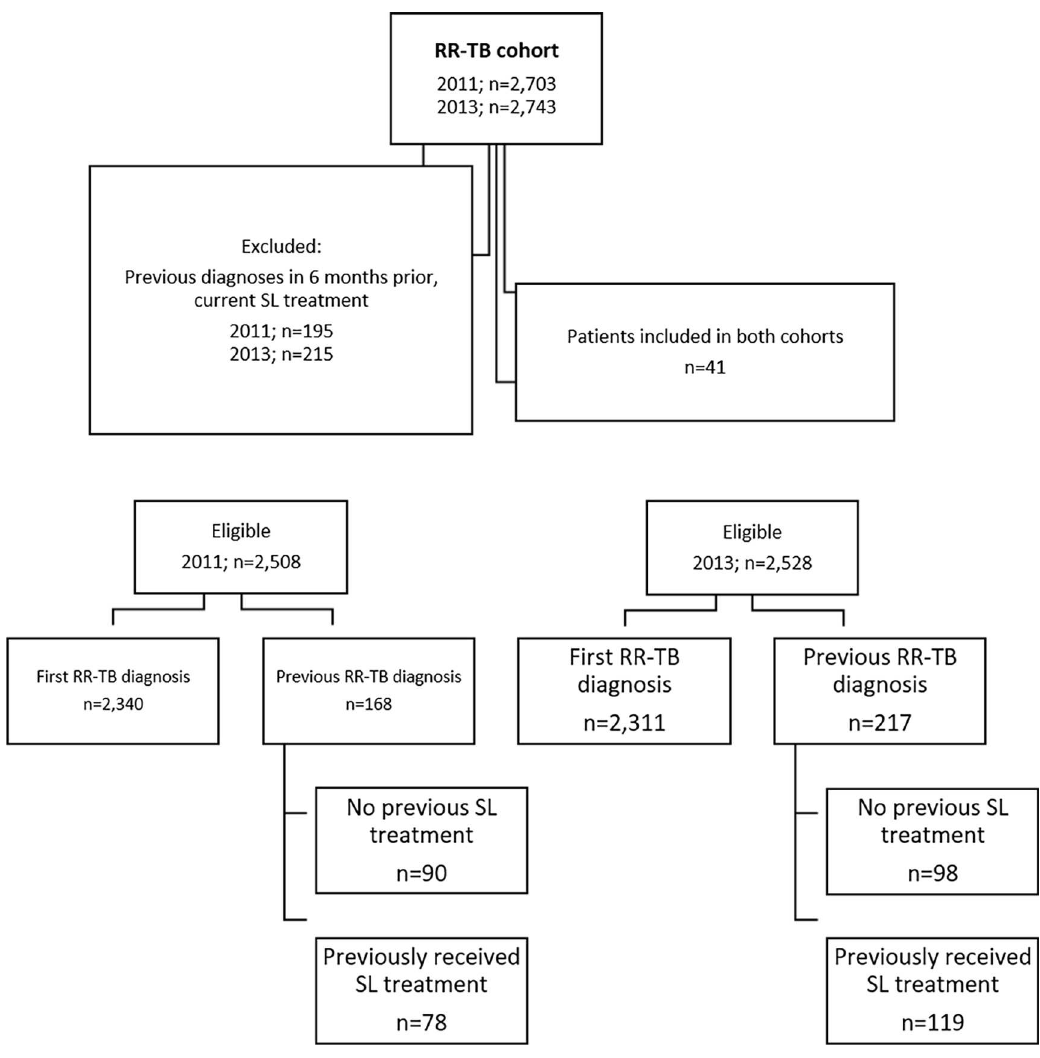
Fig 2. Flow diagram showing initial inclusion, exclusions, and determination of newly and previously diagnosed rifampicin-resistant tuberculosis. RR-TB, rifampicin-resistant tuberculosis; SL, second-line.